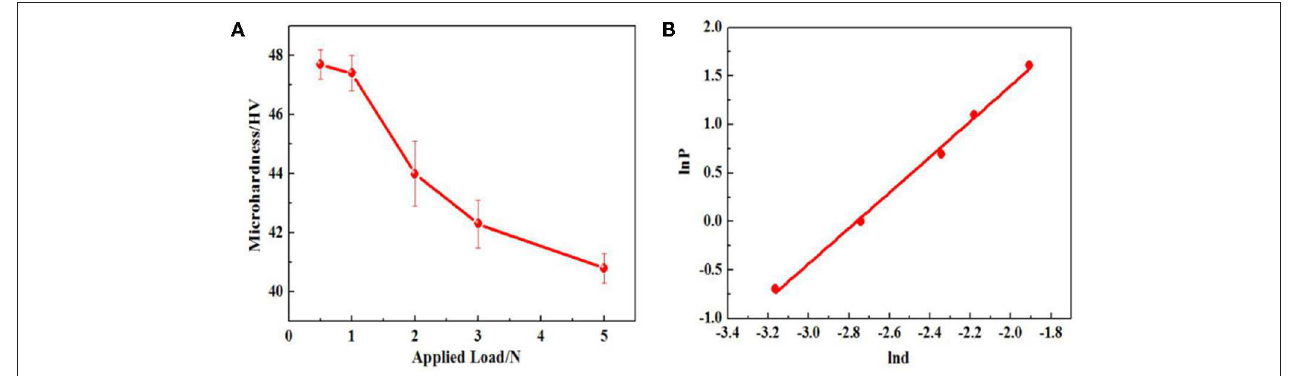
FIGURE 5 | Variations of micro-hardness with applied load for extruded dilute TMX-1.0 alloy (A) and the linear fit of lnP (B) .